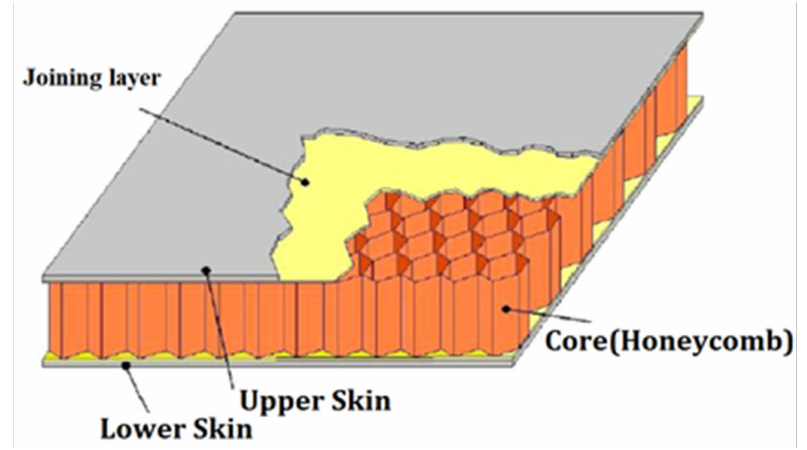
Figure 1. Typical sandwich structure